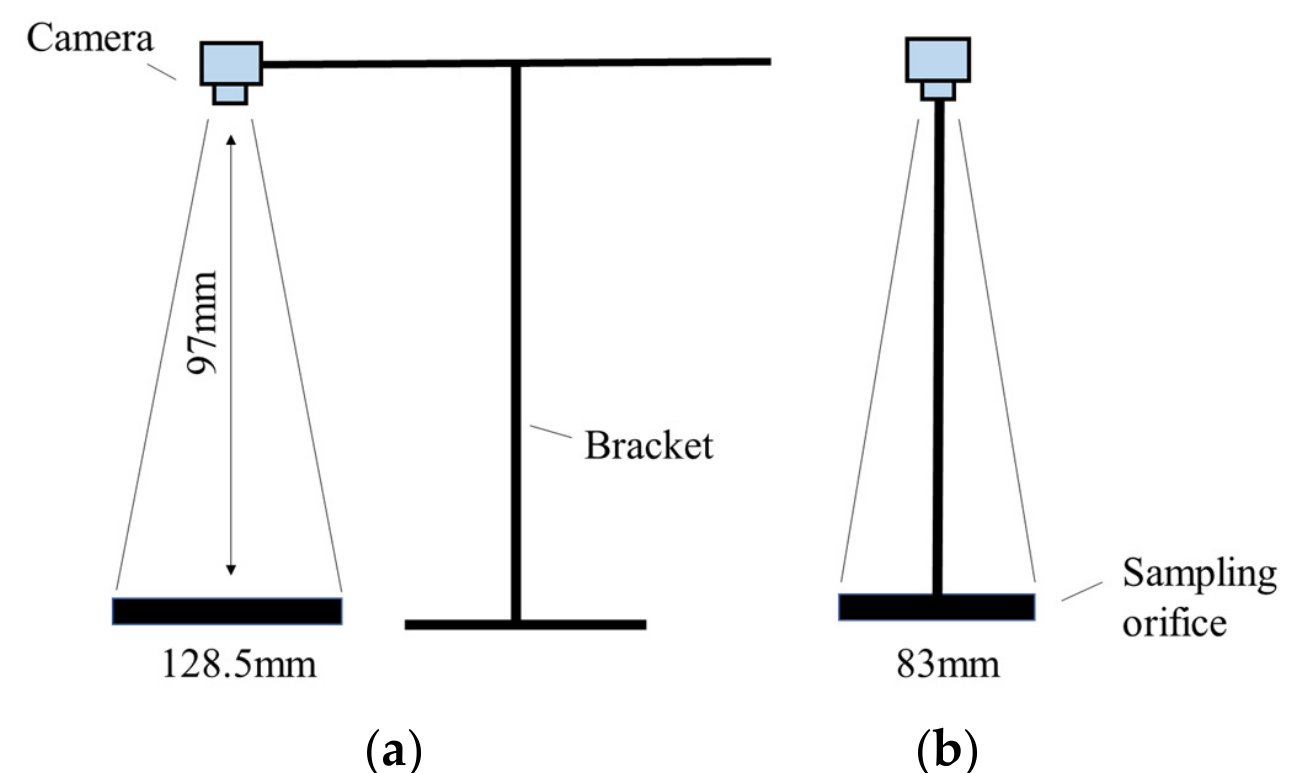
Figure 4. Diagram of camera installation. The plate size was designed to be 128.5 × 83 mm. The camera field of view was 124 × 93 mm, and the image resolution was 3264 × 2448 pixels. ( a ) Left view. ( b ) Front